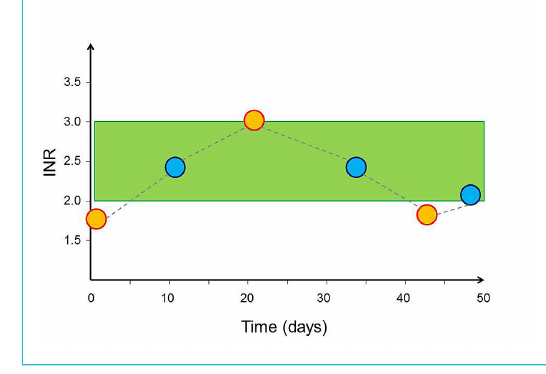
Figure 2: Hypothetical example of a patient highlighting the supe- riority of time in therapeutic range (TTR) compared with the per- centage of international normalised ratio (INR) values in the thera- peutic range to estimate the time spent in the therapeutic INR range of 2.0 to 3.0 (green). The percentage of INR values in the therapeutic range is 50%, whereas TTR is